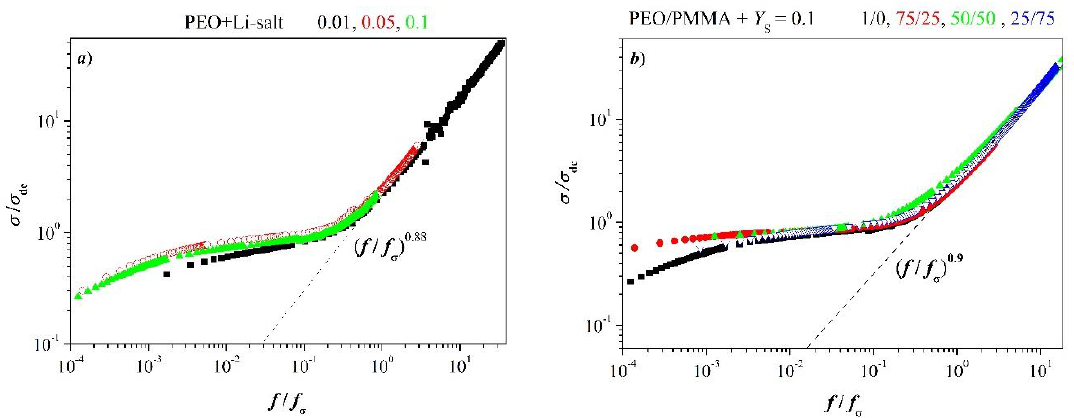
Figure 11. Scaled conductivity versus reduced frequency; power symbols stand for relationship (23), ( a ) PEO plus LiClO 4 with indicated concentration of salt at T = 298 K, ( b ) Blends PEO / PMMA with Y S = 0.1 for indicated blend composition at T = 298 K.